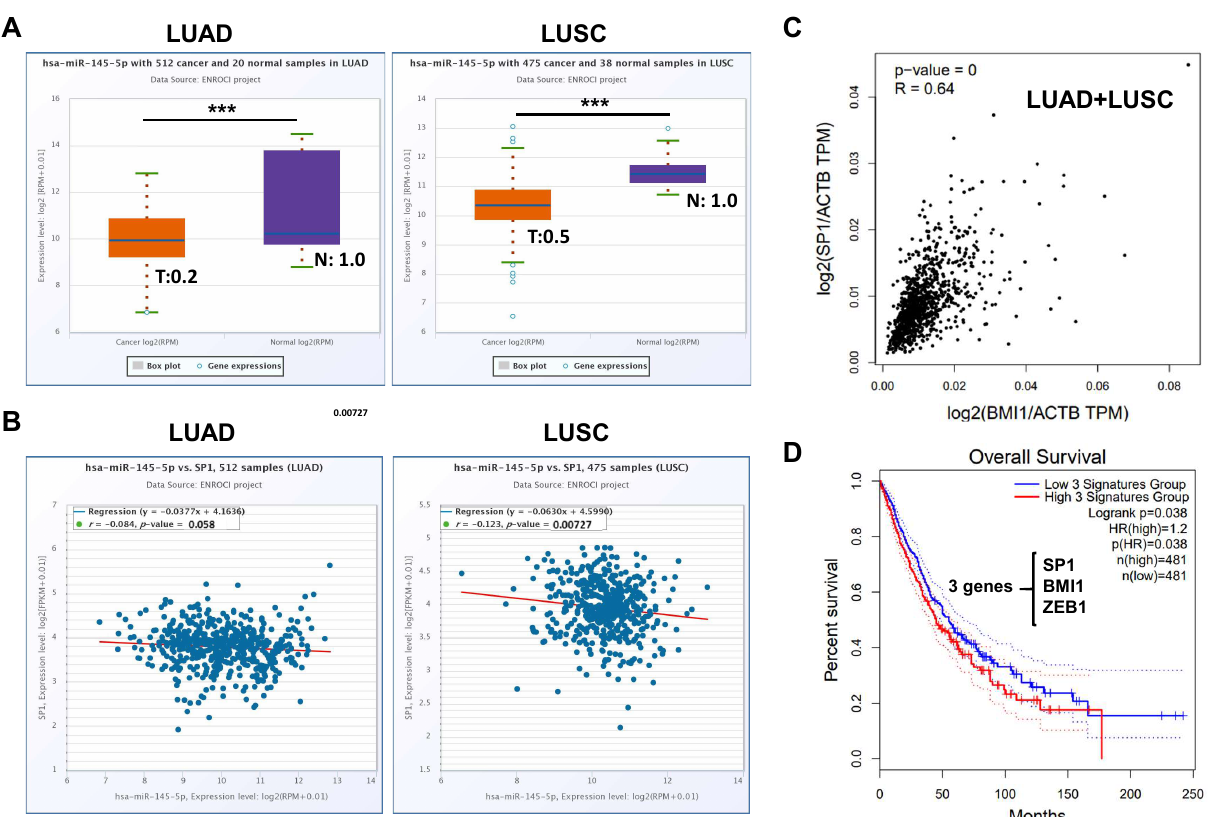
Figure 6. The correlations of BMI1, Sp1, and miR-145-5p in the lung cancer data of TCGA. ( A ) The RNA expression levels of miR-145-5p in normal lung tissues or cancer tissues of lung adenocarcinoma (LUAD) or lung squamous cell carcinoma (LUSC) were obtained from the TCGA database and analyzed using the ENCORI webtool [24]. T, tumor; N, normal. The number indicates the relative fold change in the tumor samples using normal samples as the reference. The statistical analysis was performed by the unpaired t -test. ***, p < 0.001. ( B ) The correlations between miR-145-5p and Sp1 mRNA expression in LUAD or LUSC were obtained from ENCORI and statistical analysis was performed by Spearman’s correlation. ( C ) The correlation between BMI1 and Sp1 mRNA in the NSCLC subjects (LUAD + LUSC) in the TCGA database was obtained from the GEPIA2 website [25] and the statistical analysis was performed by Spearman’s correlation. ( D ) Survival analysis based on a 3-gene-signature consisted of SP1/BMI1/ZEB1 in the NSCLC subjects of the TCGA database was analyzed using the GEPIA2 webtool with a cutoff set by the median expression level. The statistical analysis was performed by a log-rank